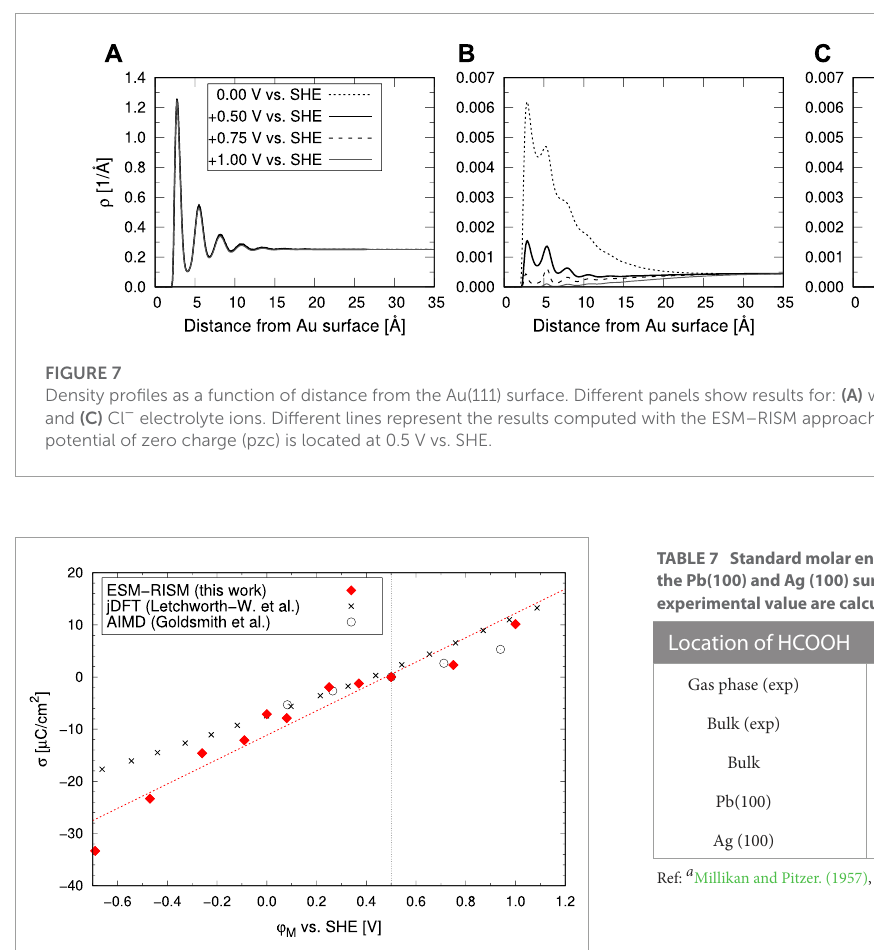
FIGURE 8 The computed surface charge vs. the applied electrode potential for the Au(111)/electrolyte interface in 0.1 M aq. HCl solution (our data), in pure water by Goldsmith et al. (2021) and in an electrolyte of 1 M ionic strength by Letchworth-Weaver and Arias (2012). The dashed red line represents a linear fit to our data. The vertical dashed line shows the pzc assumed here [0.5 V vs. SHE (Le et al., 2017)].